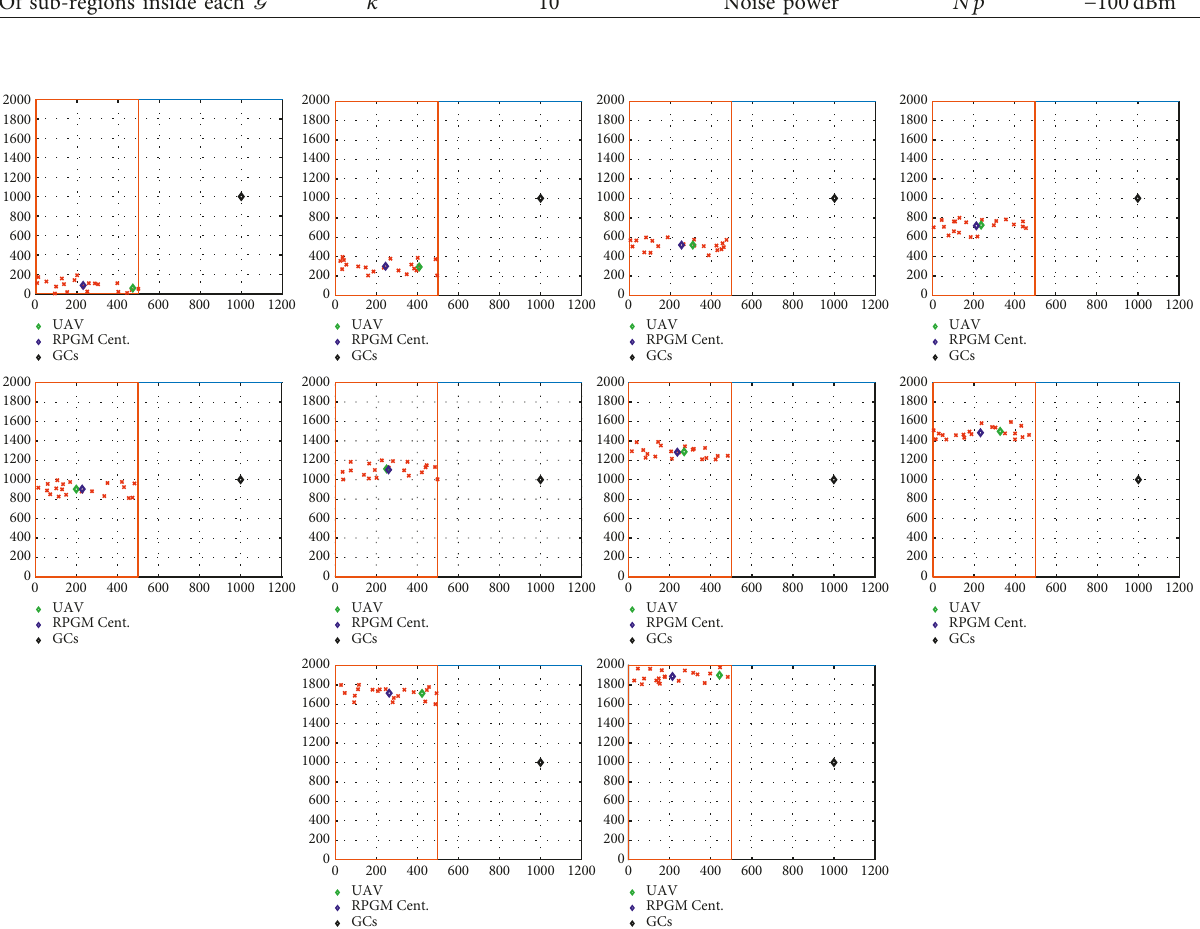
Figure 3: Users movement and trajectory based on RPGM inside the sub-area from T1 to T10. The dimensionalities of the axes are meters.